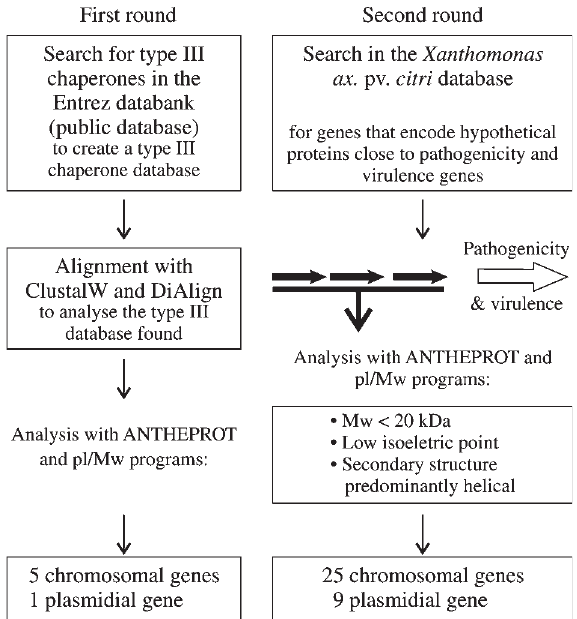
Figure 1 - Schematic representation of the two strategies used to search the Xanthomonas axonopodis pv citri genome for potential type III chaperone genes. The figure schematically represents the two strategies used to search the Xanthomonas axonopodis pv citri genome (da Silva et al. , 2002) for potential type III chaperone genes. See Material and Methods for details and software